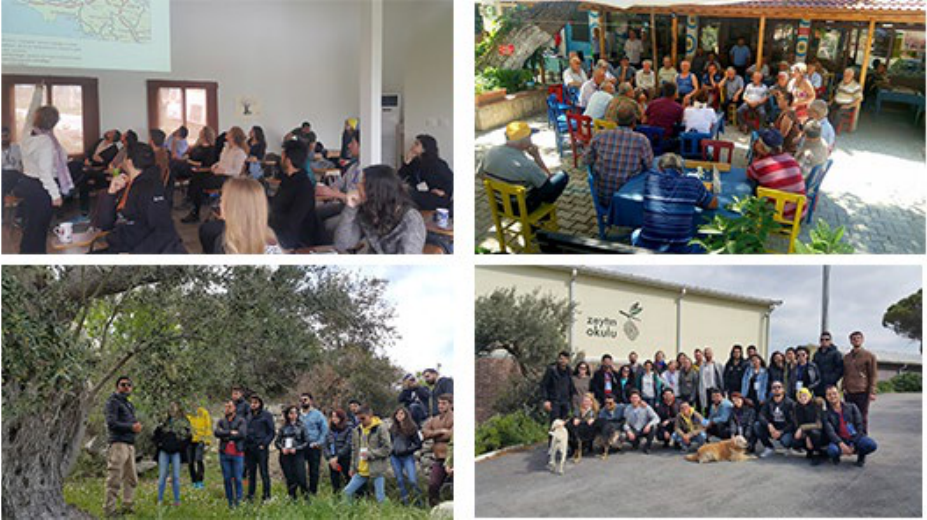
Figure 3 Bioblitz Peninsula Citizen Science Practice